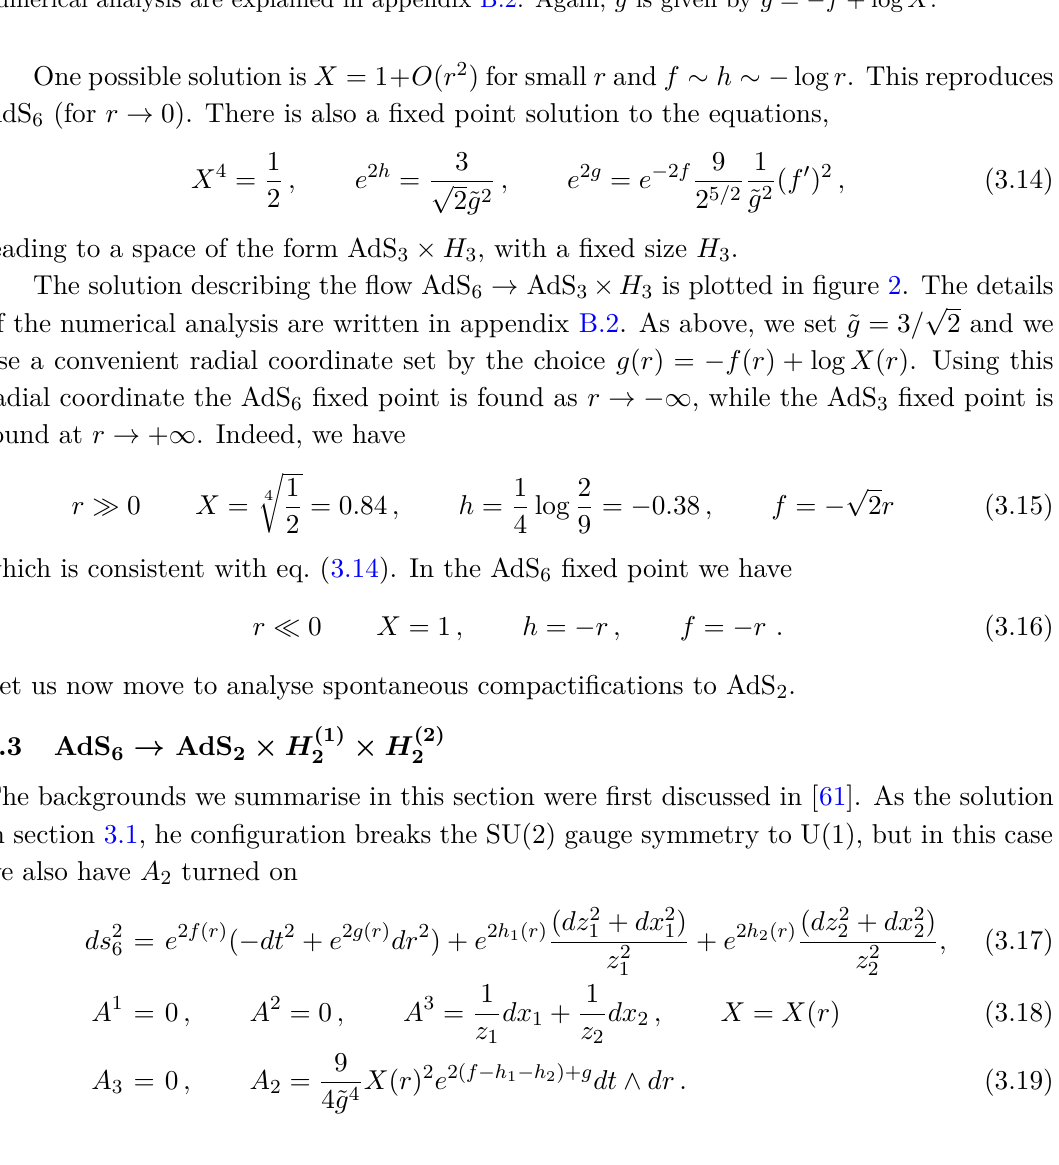
Figure 2 . Numerical interpolation between the AdS 6 and AdS 3 fixed point. The details of the numerical analysis are explained in appendix B.2. Again, g is given by g = − f + log X .